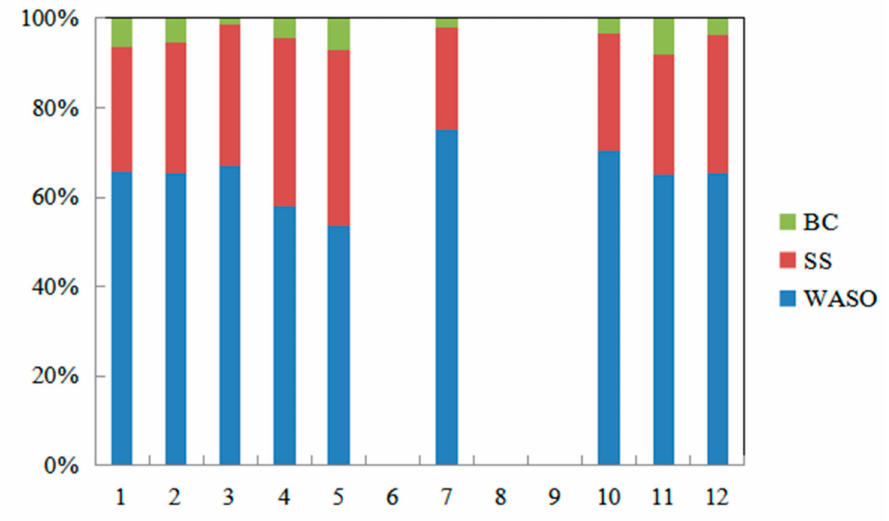
Figure 4. Monthly average proportions of the three components in